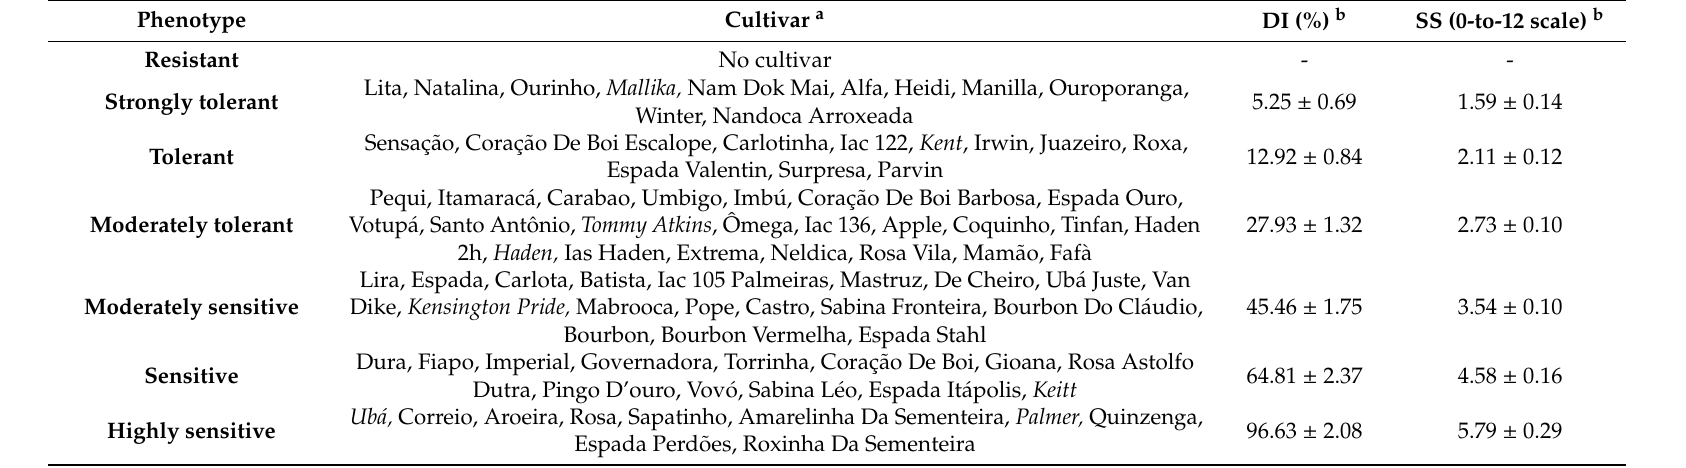
Table 2. Mango cultivars grouped for susceptibility phenotype to anthracnose infections and relative DI and severity